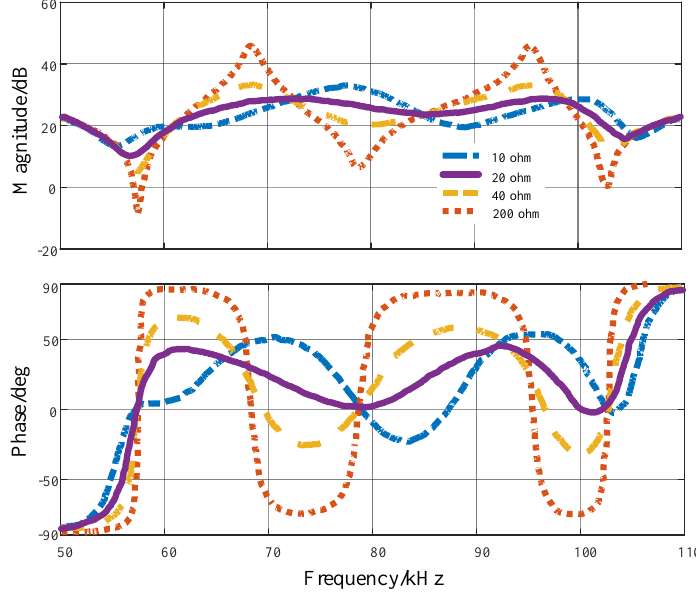
Figure 9. Frequency characteristics of the input impedance.